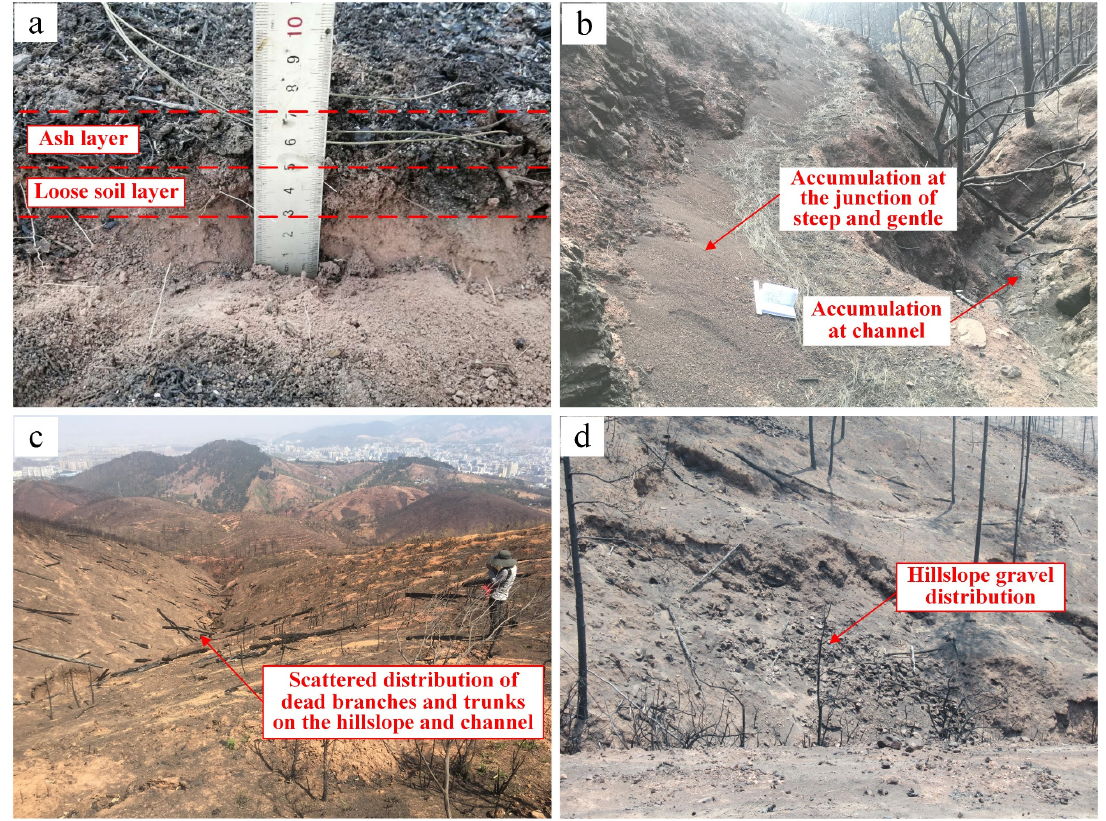
Figure 4. Characteristics of burned areas: ( a ) hillslope ash and loose soil layer formed by vegetation burning and high-temperature baking; ( b ) a large amount of ash and loose sediment deposited at channels and the junction of steep and gentle hillslopes; ( c ) distribution of dead branches and trunks on channels and hillslopes; ( d ) distribution of gravel on channels and hillslopes.